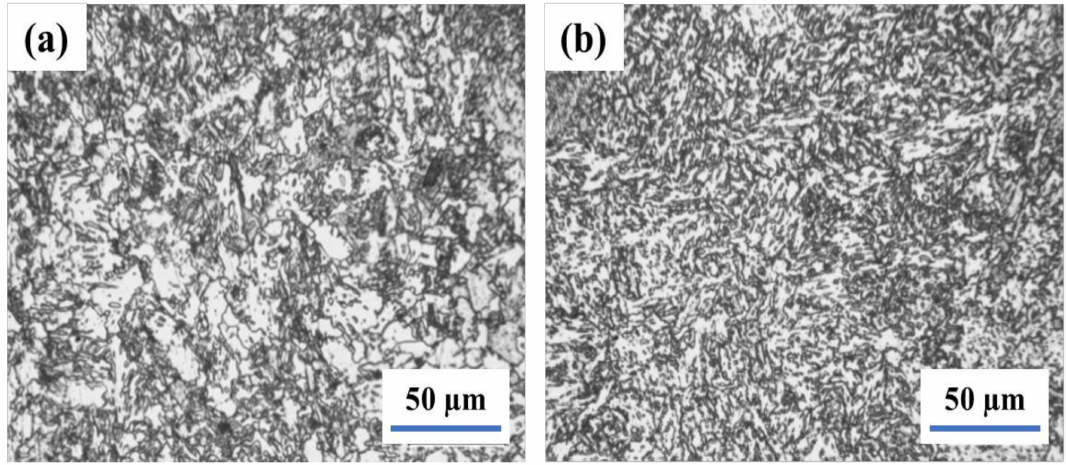
Figure 3. The Microstructure of weld joint after normalizing at 920 ◦ C − weld ( a ) and HAZ ( b